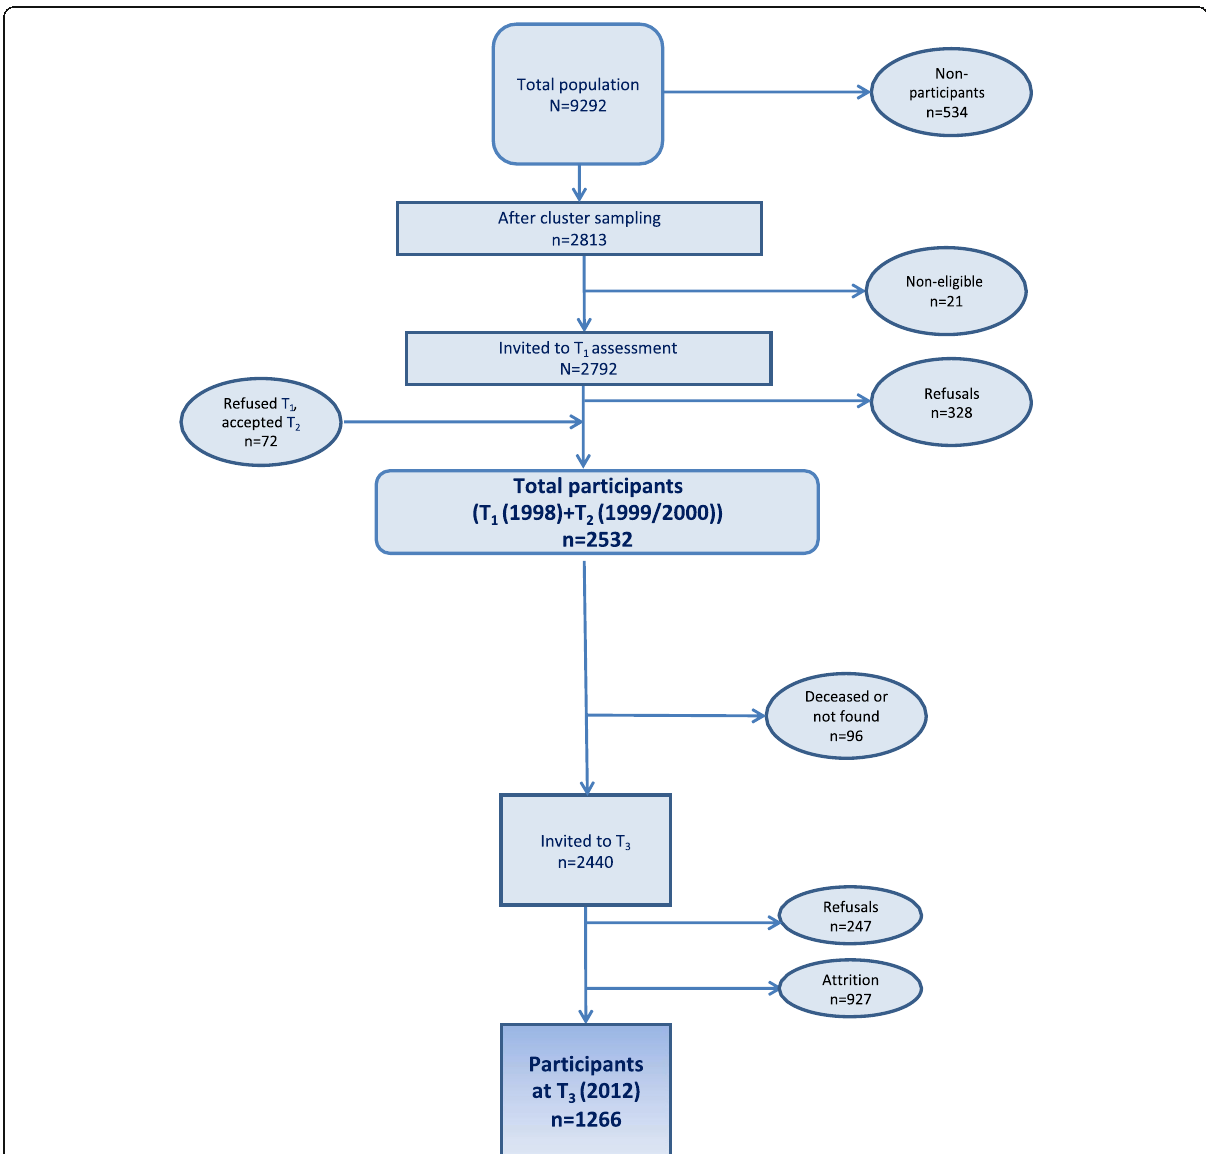
Fig. 1 Participant flow in the Youth and Mental Health